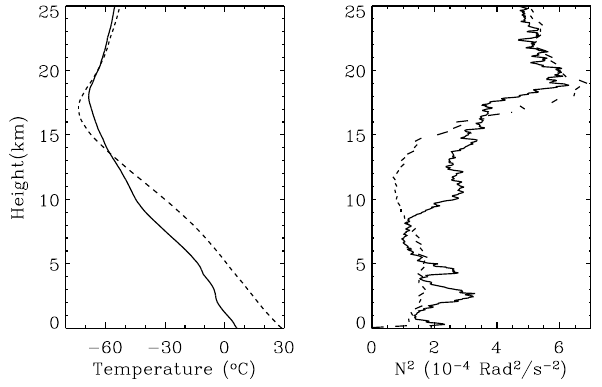
Fig. 1. Monthly averaged temperatures (left panel) and squares of buoyancy frequency (right panel). The dotted and solid curves rep- resent the observation values in summer (August 2006) and winter (January 2007),